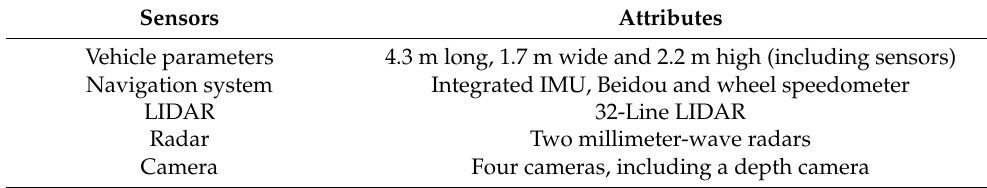
Table 5. The main configurations and sensors on our autonomous vehicles.